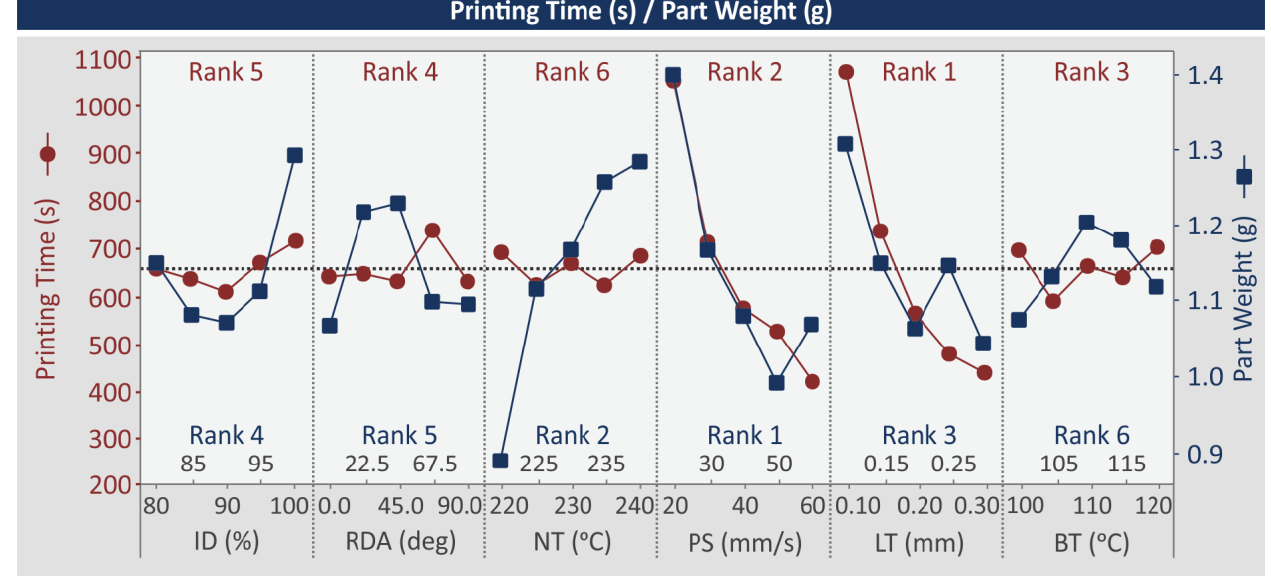
Figure 8. MEP: printing time (s), part weight (g).